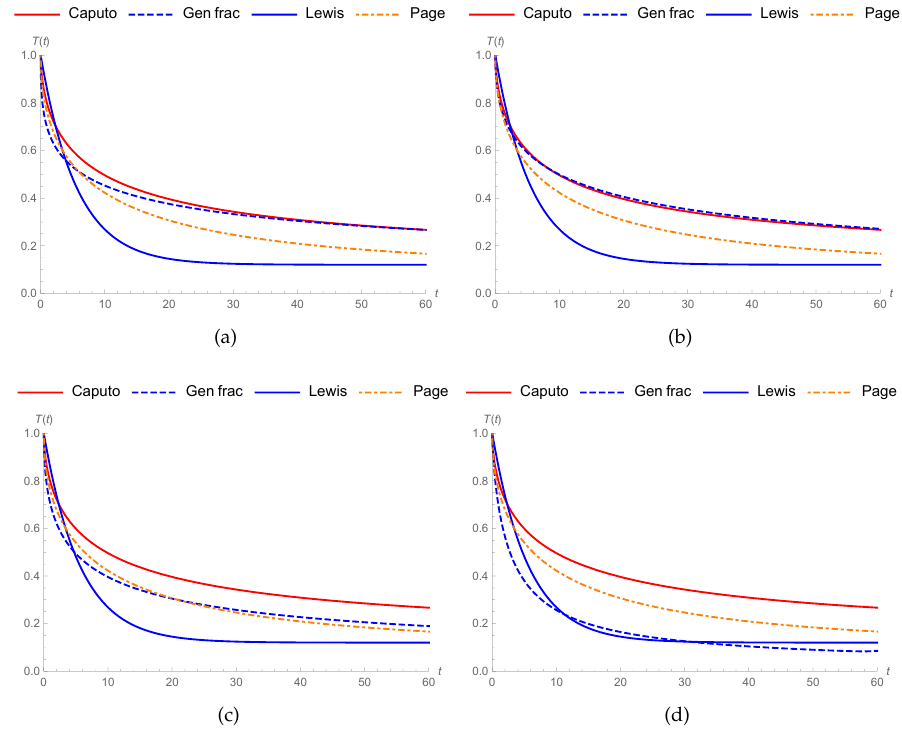
Figure 1. Comparison of drying kinetics for soybean under different models at 50 ◦ C: ( a – d ) Parameter values are shown in Table 1.